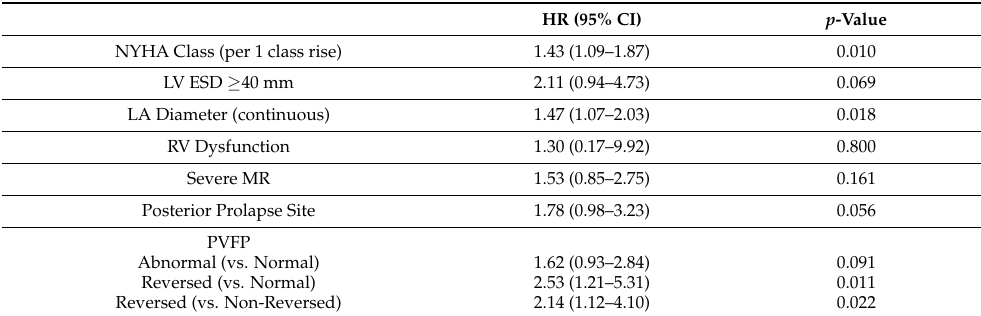
CI = confidence interval; EF = ejection fraction; ESD = end-systolic diameter; HR = hazard ratio; LA = left atrial; LV = left ventricular; MR = mitral regurgitation; NYHA = New York Heart Association; PVFP = pulmonary venous flow pattern; RV = right